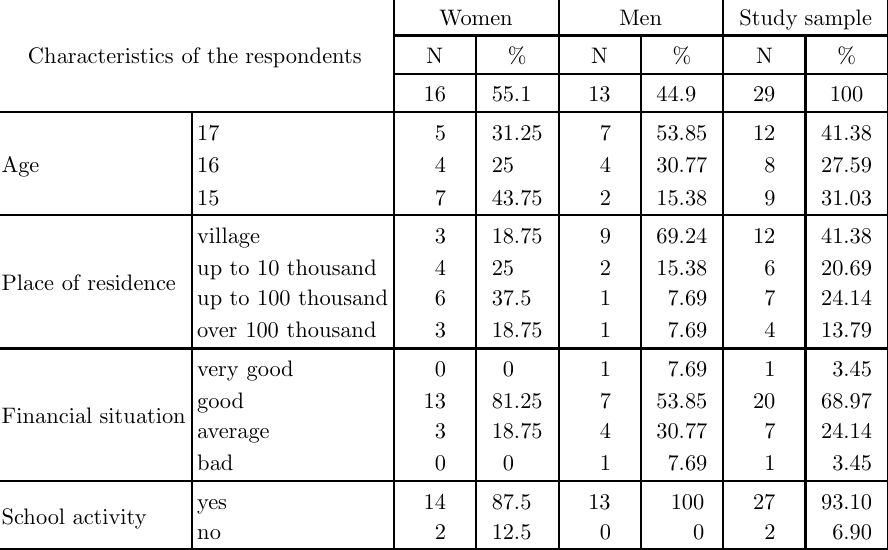
Table 1. Characteristics of the surveyed patients Women Men Study sample Characteristics of the